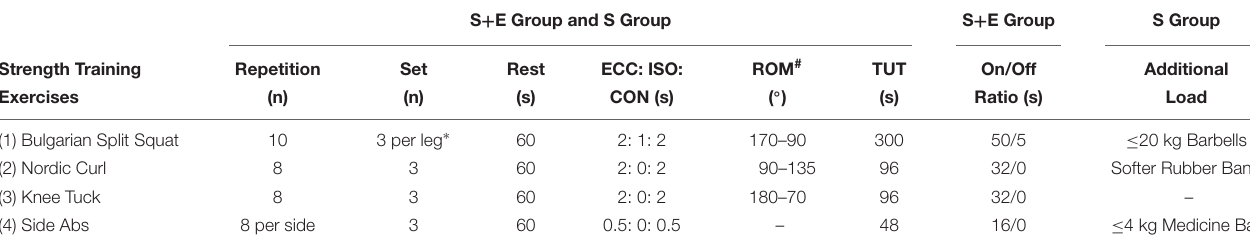
TABLE 2 | Strength training exercises with characteristics about repetitions, sets, rest between the sets, contraction mode (ecc = eccentric, iso = isometric, con = concentric) per repetition, range of motion per repetition and time under tension (TUT) per exercise for both groups as well as on/off ratio of WB-EMS impulse (70% of the individual pain threshold) for the strength training group with superimposed WB-EMS (S + E) and additional load (individual 8–10 repetition maximum) for the strength training group (S).